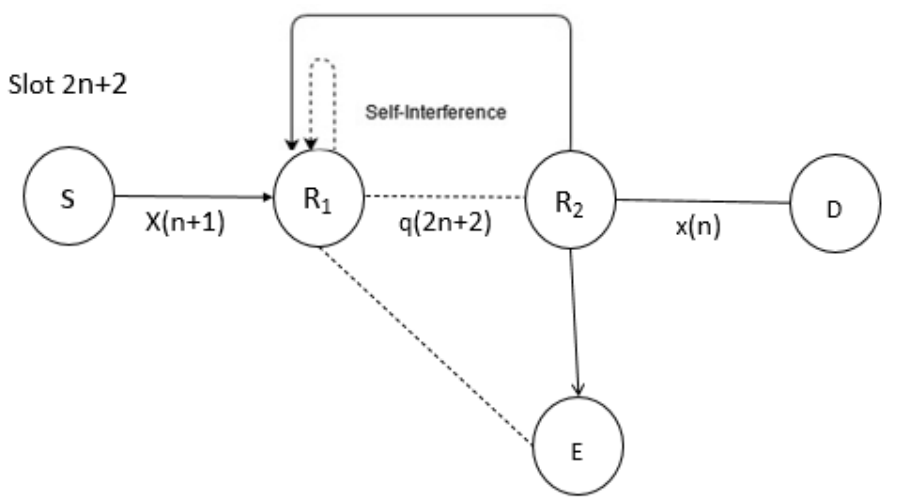
Figure 5. Signal transmission in the 2( n +2)th time slot .